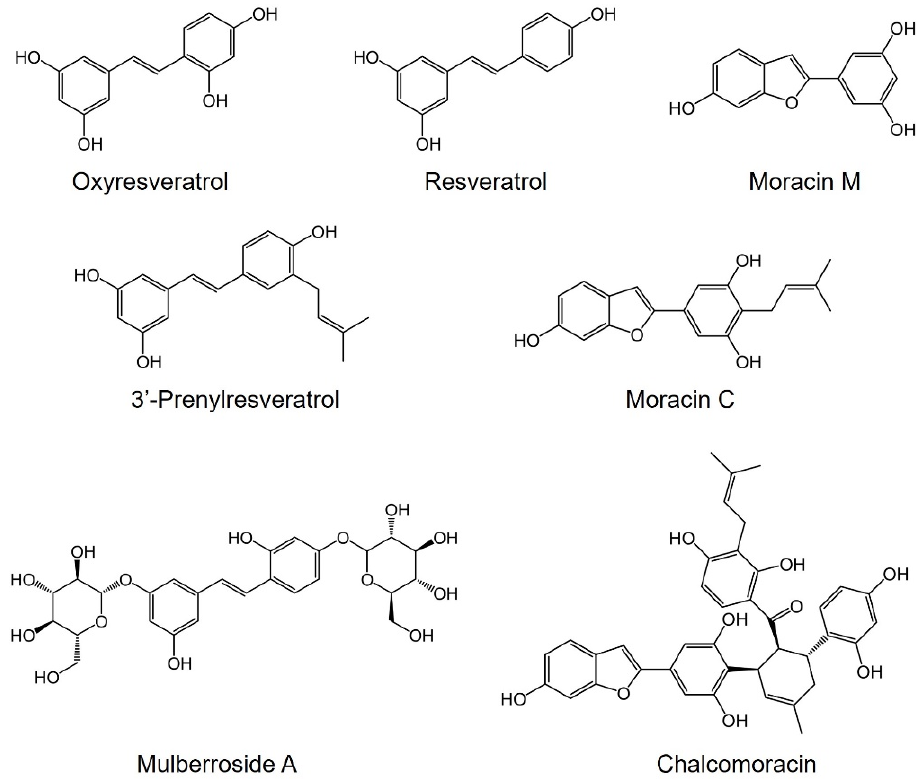
Figure 1. Chemical structures of stilbenes and benzofurans identified in hairy root cultures of white mulberry.